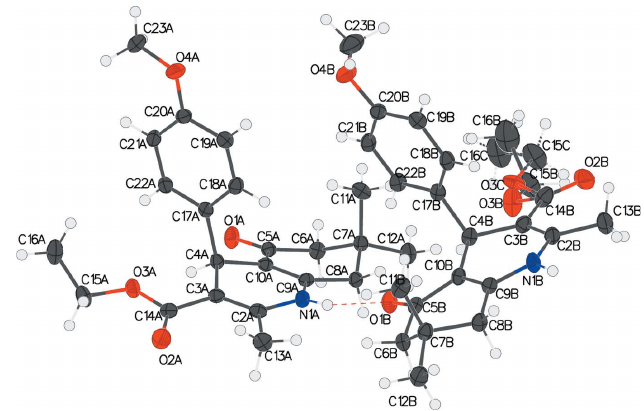
Figure 2 The asymmetric unit of compound II showing the atom-labeling scheme. Displacement ellipsoids are drawn at the 50% probability level. The intermolecular hydrogen bond between N1 A —H1 A and O1 B is shown as a dashed line.